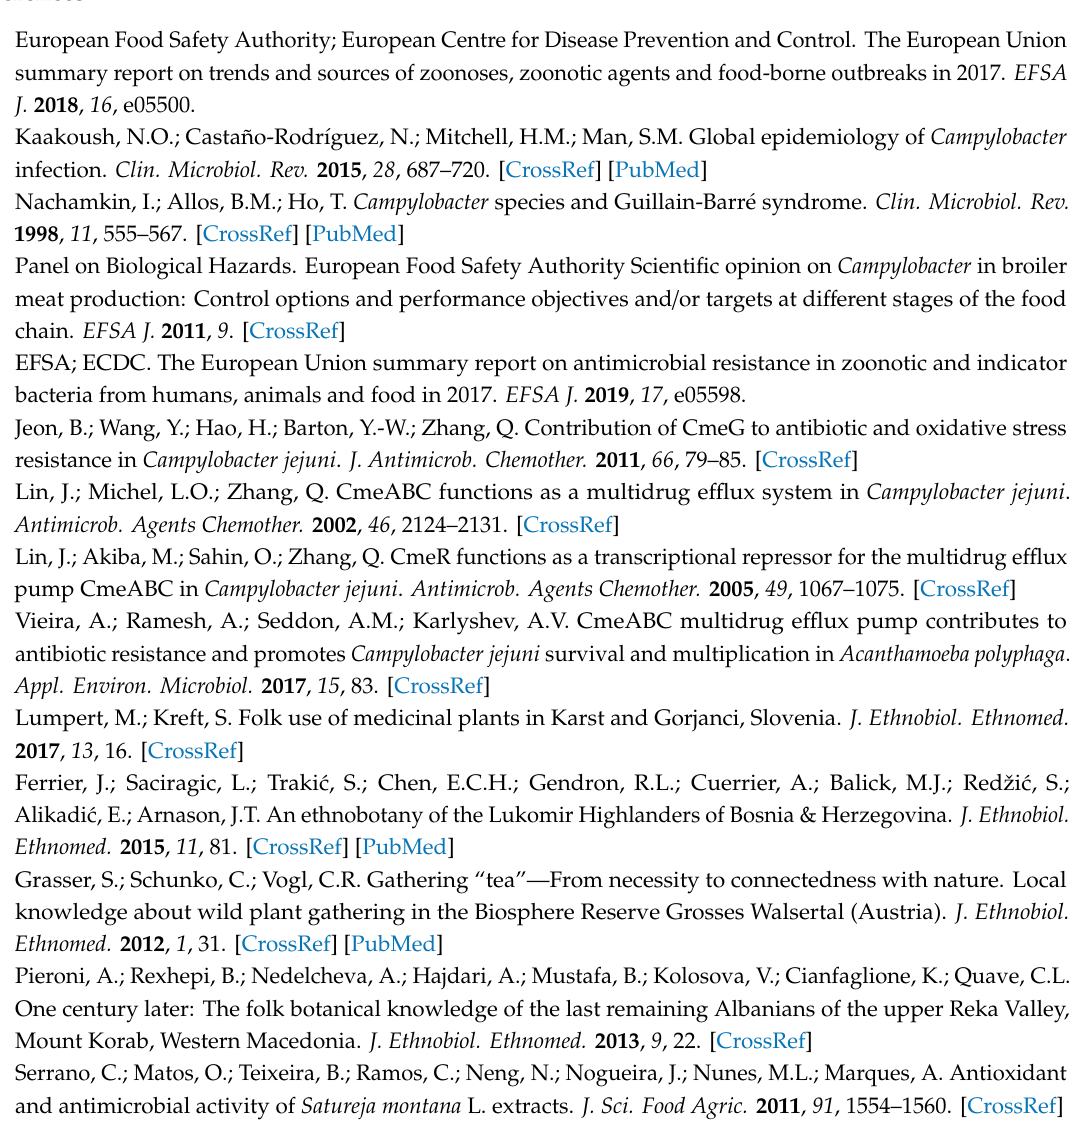
Table S1: Strain designation, description and reference of strains used in the study, Table S2: UHPLC-PDA-ESI-MS analysis of the ethanolic extract of Satureja montana herbal parts, Table S3: Chemical analysis of S. montana essential